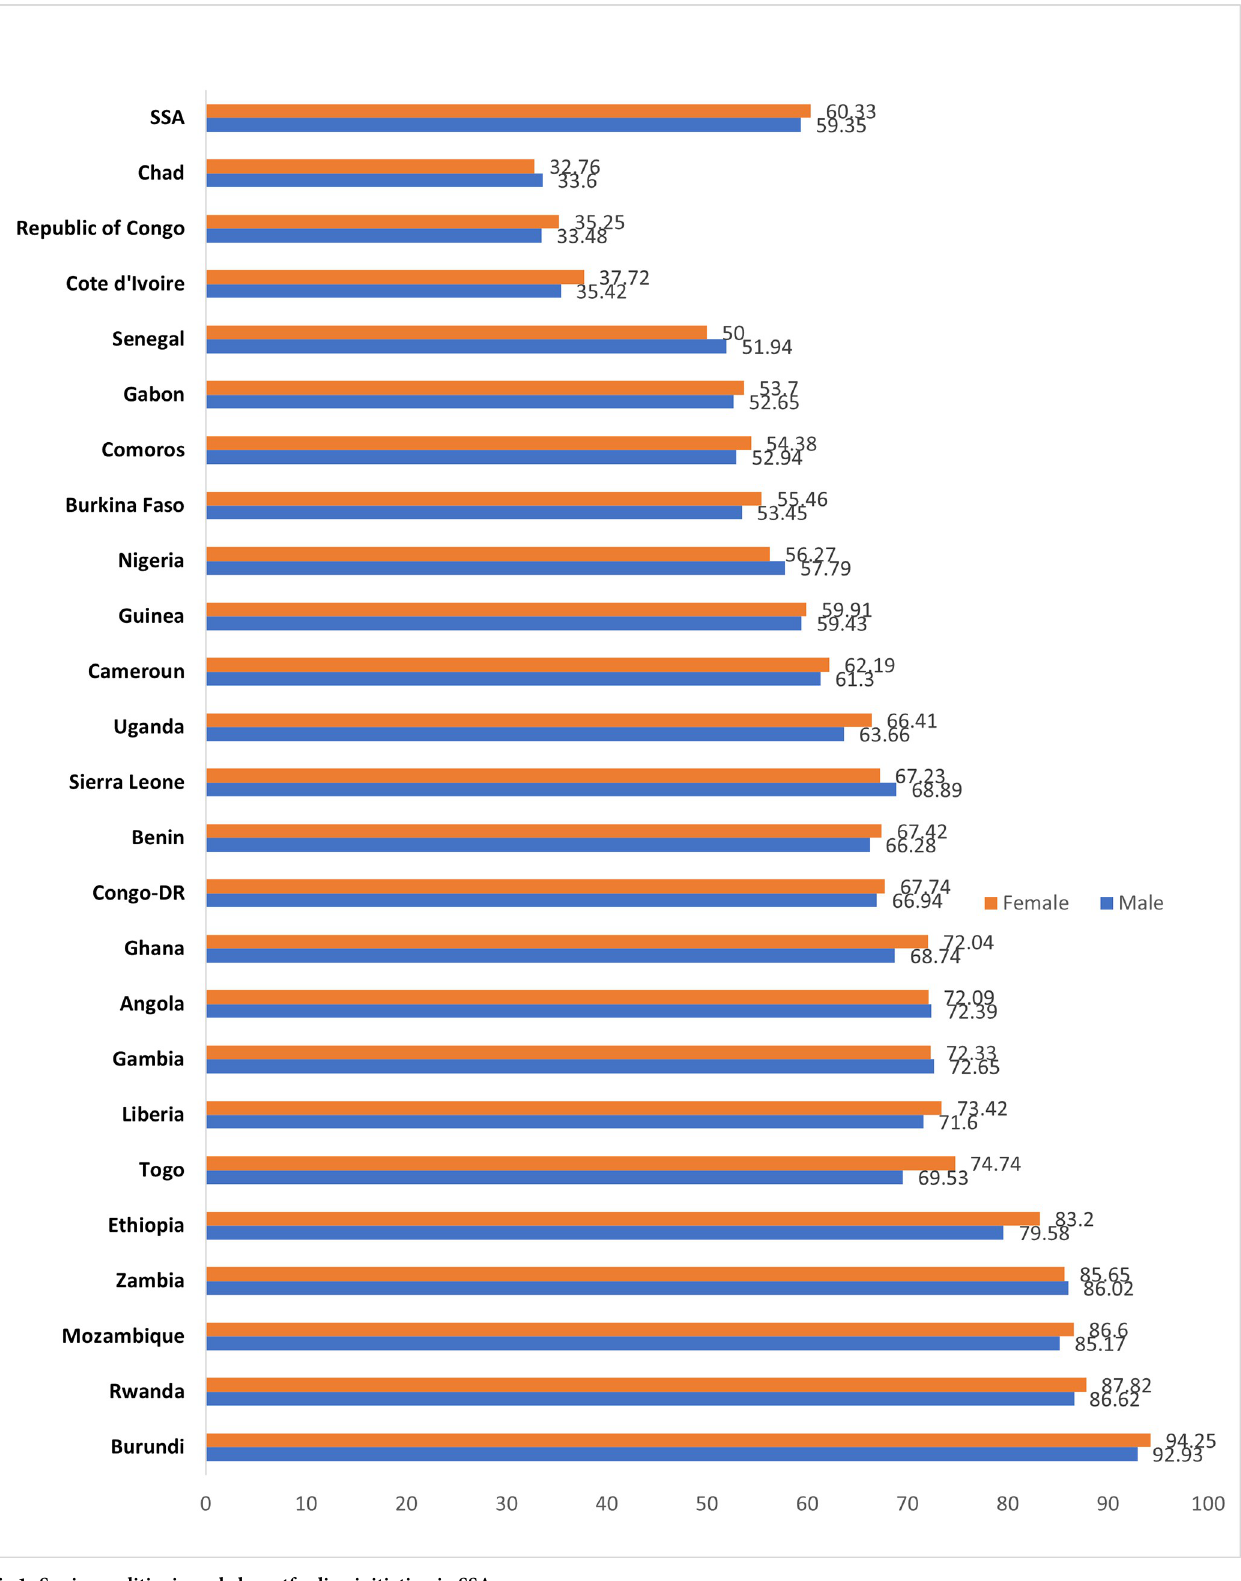
Fig 1. Sex inequalities in early breastfeeding initiation in SSA. https://doi.org/10.1371/journal.pone.0267703.g001 PLOS ONE | https://doi.org/10.1371/journal.pone.0267703 May 19,